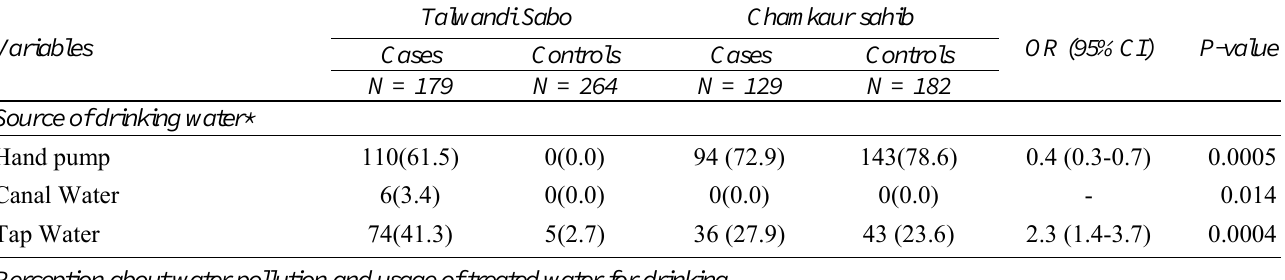
Table: 4: Pattern of usage of Drinking Water and other Risk factors among cases and controls